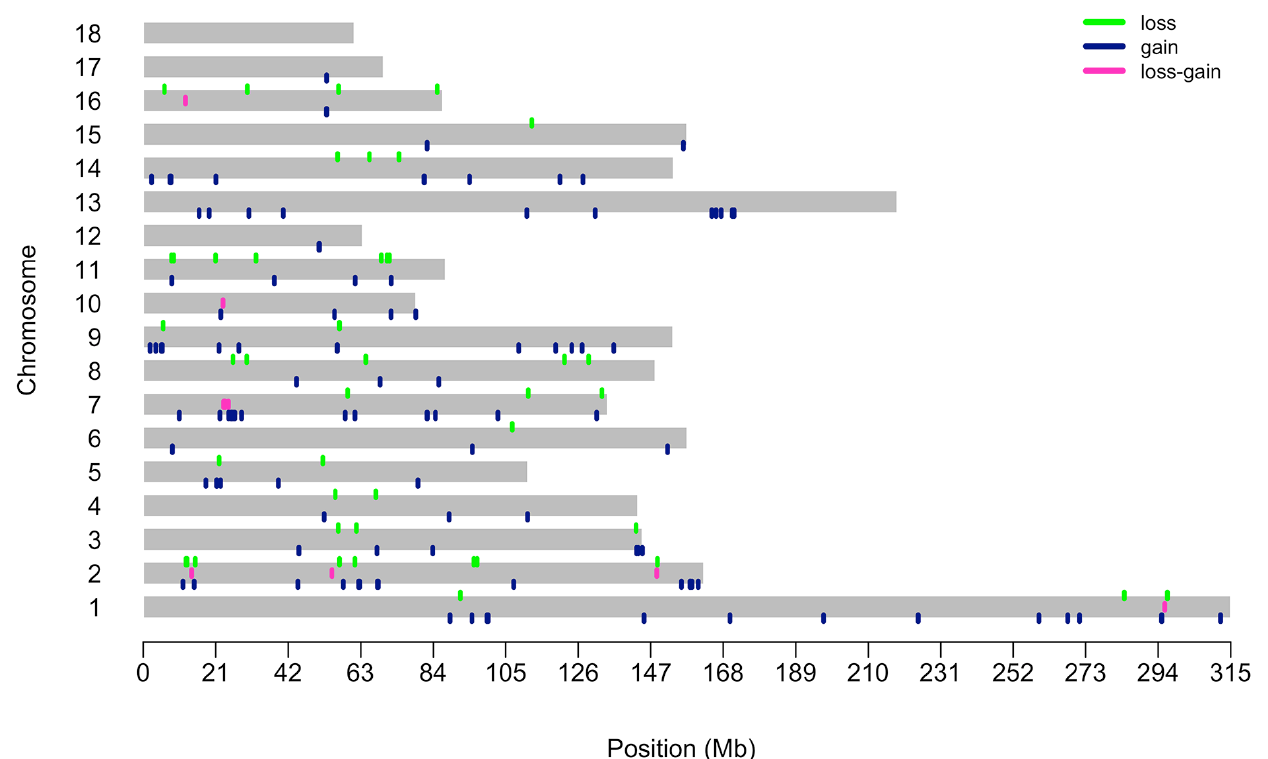
Figure 1. Distribution of copy number variation regions in the genome of Dongxiang spotted pigs. The X-axis values represent the chromosome position in Mb on the Sus scrofa 10.2 reference genome assembly. The Y-axis show all autosomal chromosomes.